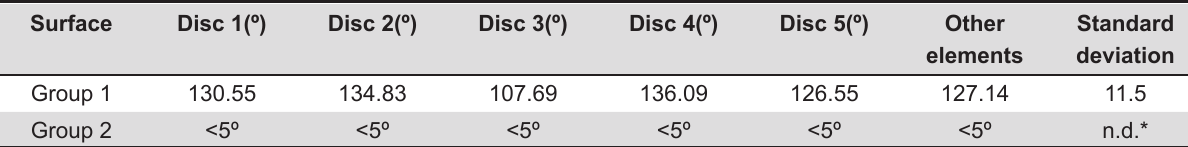
Table 1- Contact angle of different surfaces (goniometer)